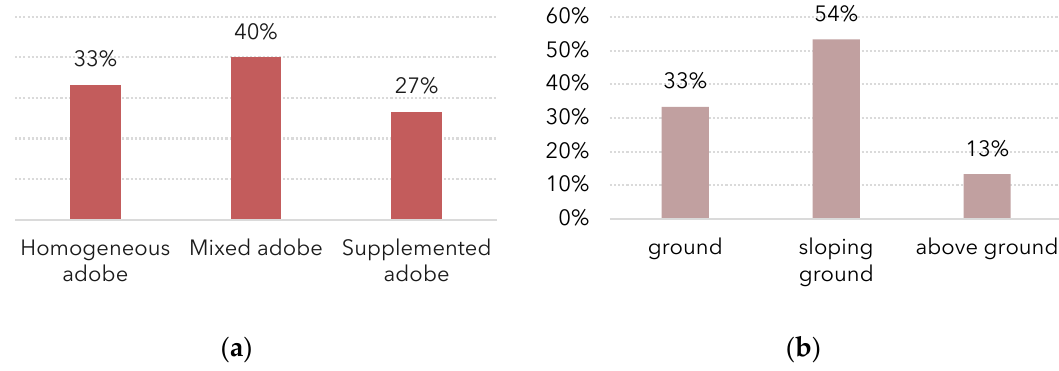
Figure 6. ( a ) Percentage distribution graph of the adobe construction system; ( b ) Percentage distribution graph of the urban locations of the assets.